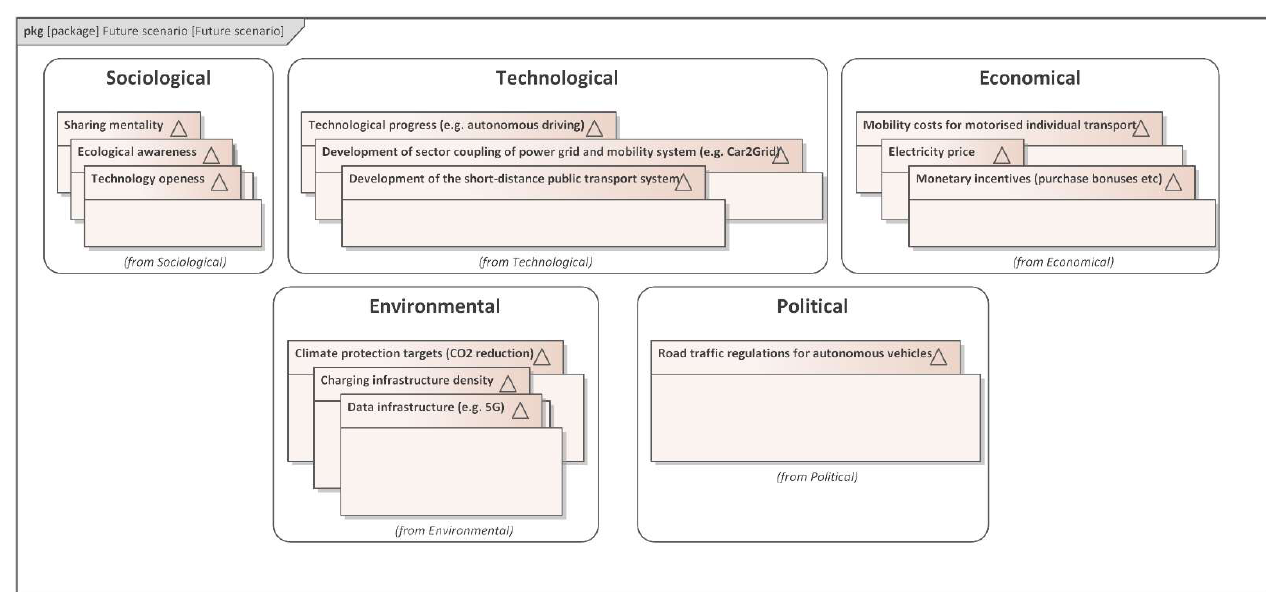
Figure A1. Overview of the STEEP descriptors .